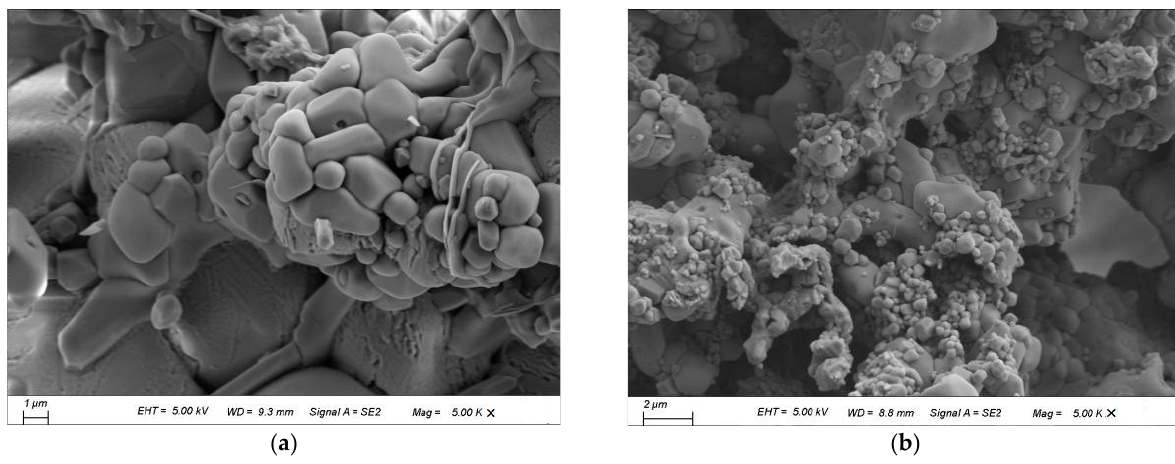
Figure 9. SEM micrographs of cement clinkers with 0.3% Na 2 O. ( a ) BCSA; ( b ) TCSA.